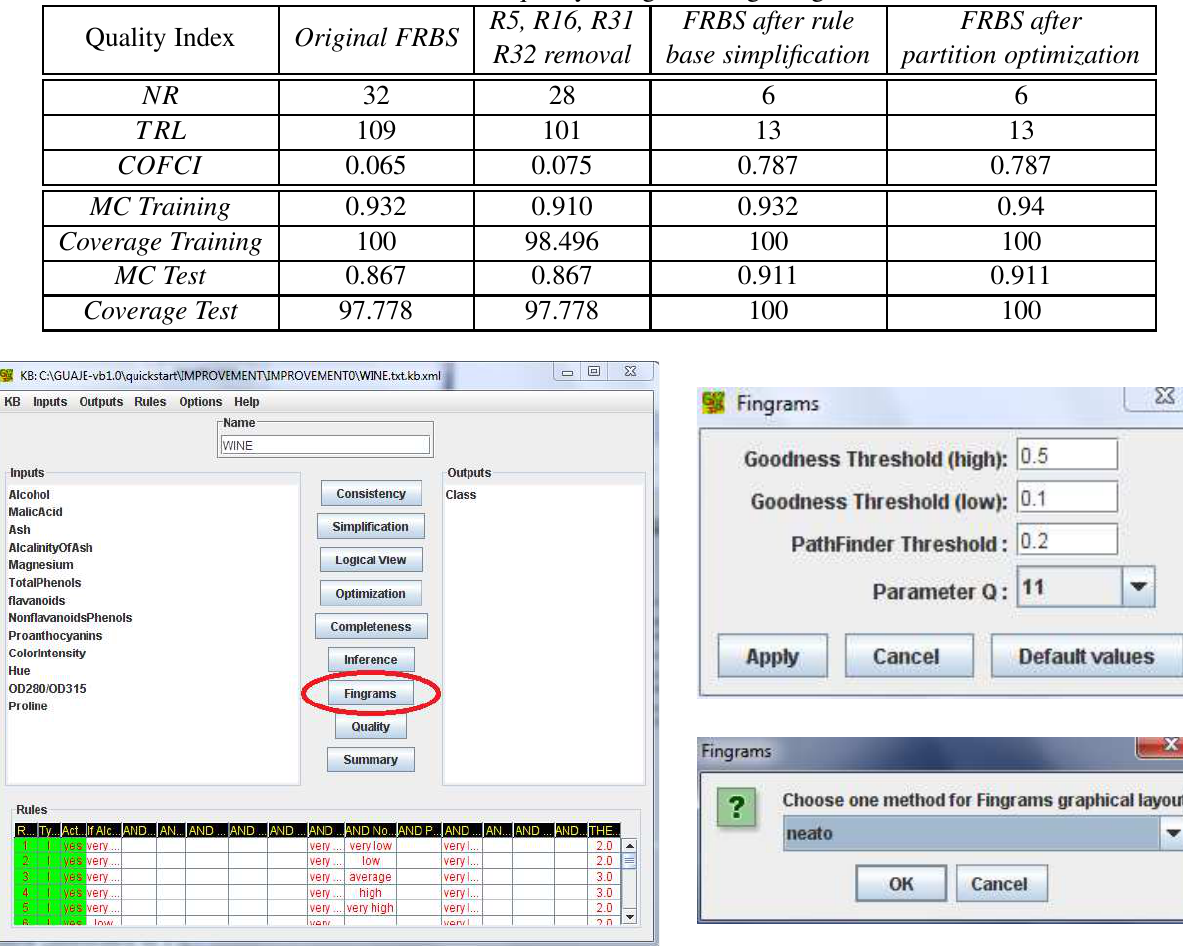
Figure 4: Generation of